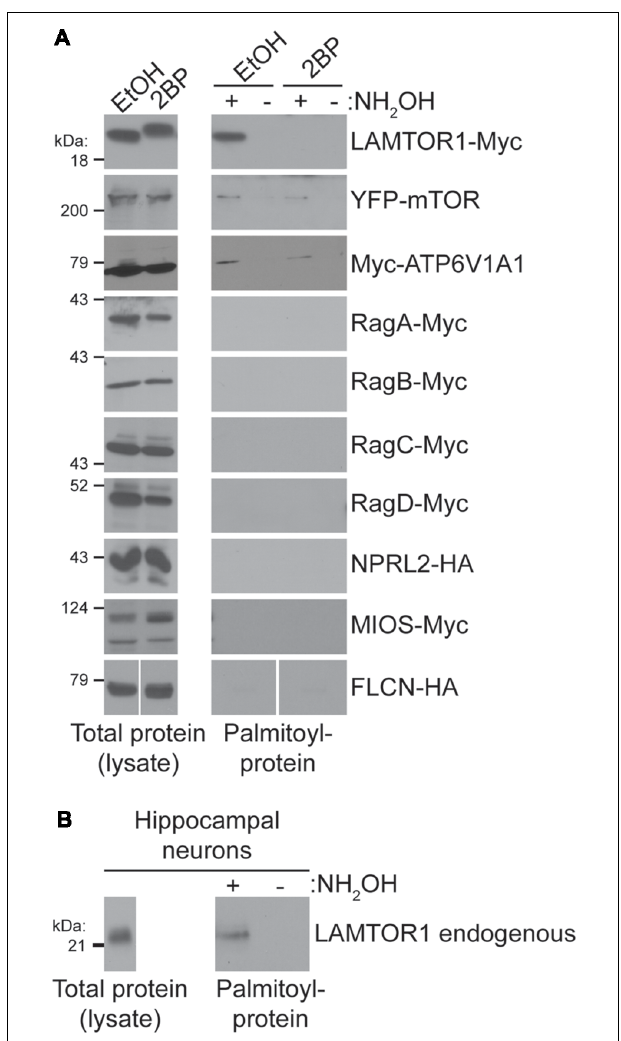
FIGURE 4 | (A) Candidate-based screen of putative palmitoylated proteins of the mTOR signaling pathway. HEK293T cells were transfected with the indicated constructs for 8 or 24 (mTOR only) hours and were treated with 100 µ M 2BP or EtOH at 4 h post-transfection. Palmitoyl-proteins [isolated by acyl biotin exchange (ABE); right panels] and total protein levels (in parent lysates; left panels) were assessed by western blotting with antibodies against the indicated tags. FLCN-HA panels are composites of the same Western blot image. (B) LAMTOR1 is palmitoylated in hippocampal neurons. Total LAMTOR1 (left panel) and palmitoyl-LAMTOR1 level (right panel) from DIV16 hippocampal neurons detected by western blotting.